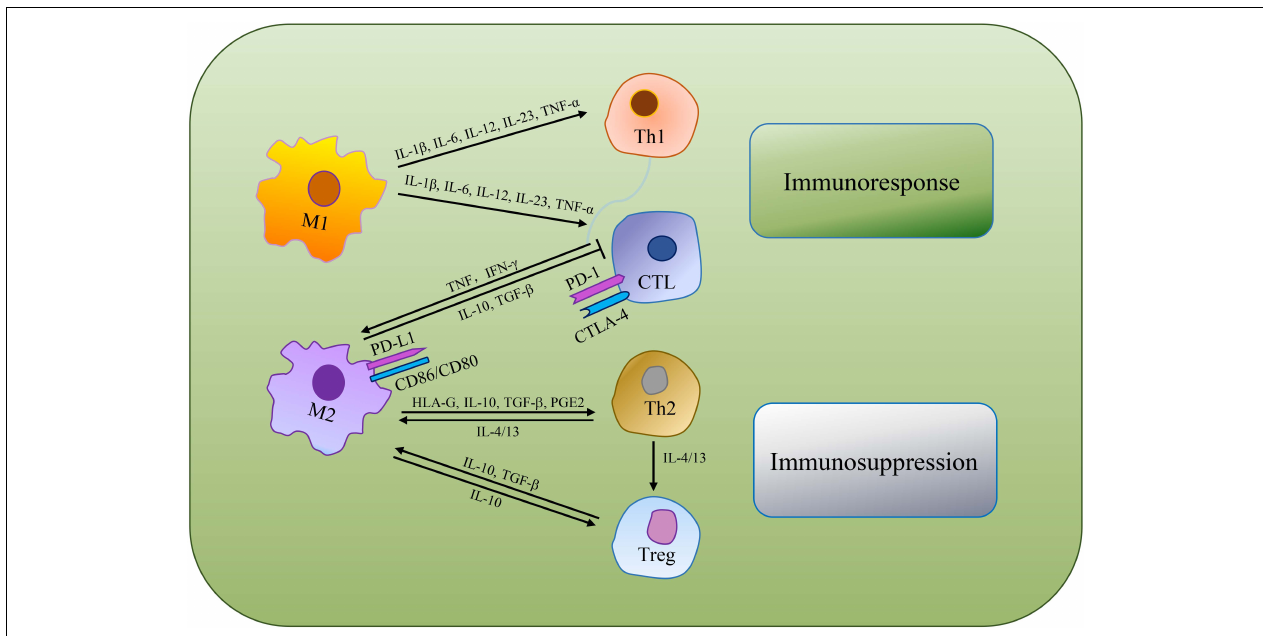
FIGURE 3 | The mechanisms of TAMs regulating tumoricidal T cells. TAMs can directly suppress CTLs or indirectly regulate the differentiation of Th cells and Tregs to make an immunosuppressive